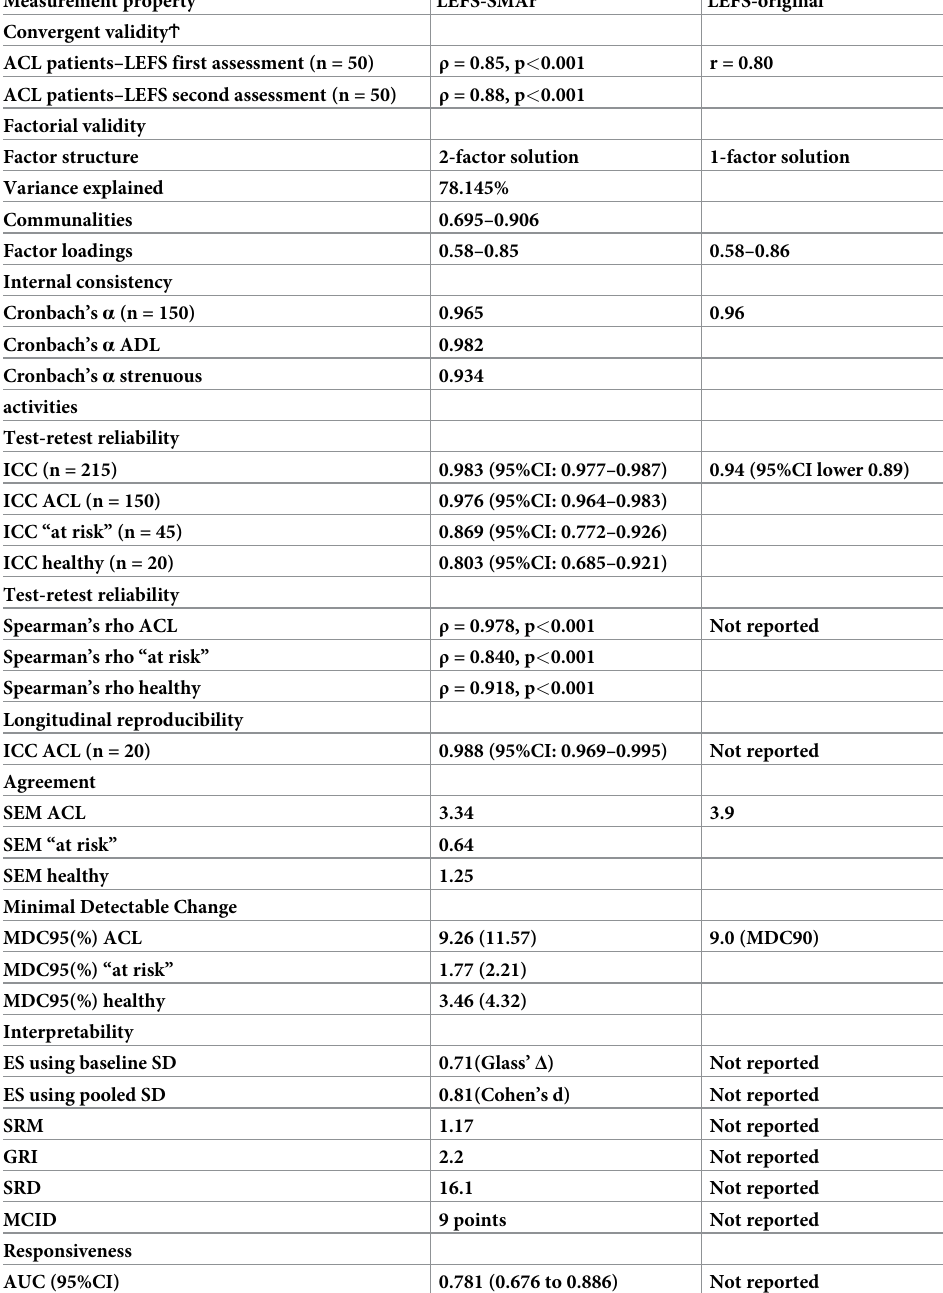
Table 4. Summary of measurement properties of the original LEFS and LEFS-SMAr